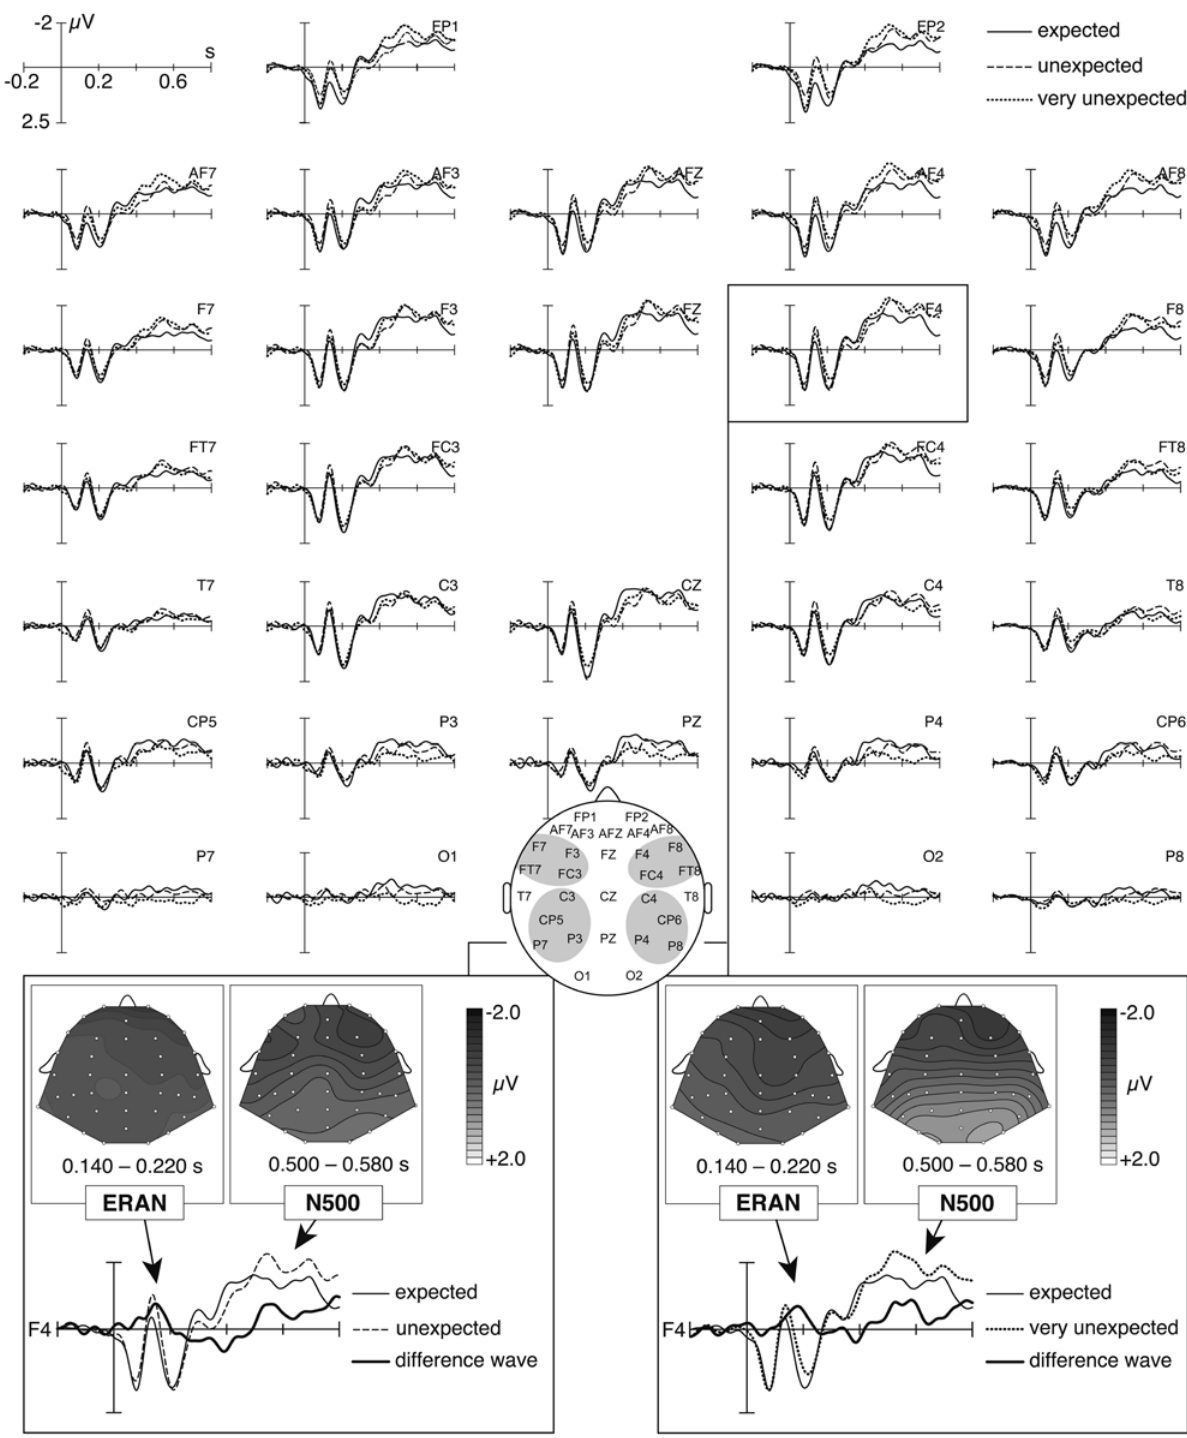
Figure 4. Grand-average of brain electric responses to expected, unexpected (original), and very unexpected chords (averaged across expressive and non-expressive conditions). Compared to expected chords, both unexpected and very unexpected chords elicited an ERAN and an N5. The insets in the two bottom panels show isopotential maps of the ERAN and the N5 effect (expected subtracted from [very] unexpected chords). doi:10.1371/journal.pone.0002631.g004 A global ANOVA with factors chord (expected, unexpected, very 220 ms indicated an interaction between factors chord, anterior- unexpected), expression (expressive, non-expressive), anterior- poste- posterior and hemisphere ( F (2,38)=3.6, p , .05, reflecting that the rior distribution, and hemisphere for a time window from 140 to ERAN amplitude was largest at right anterior leads). A follow-up